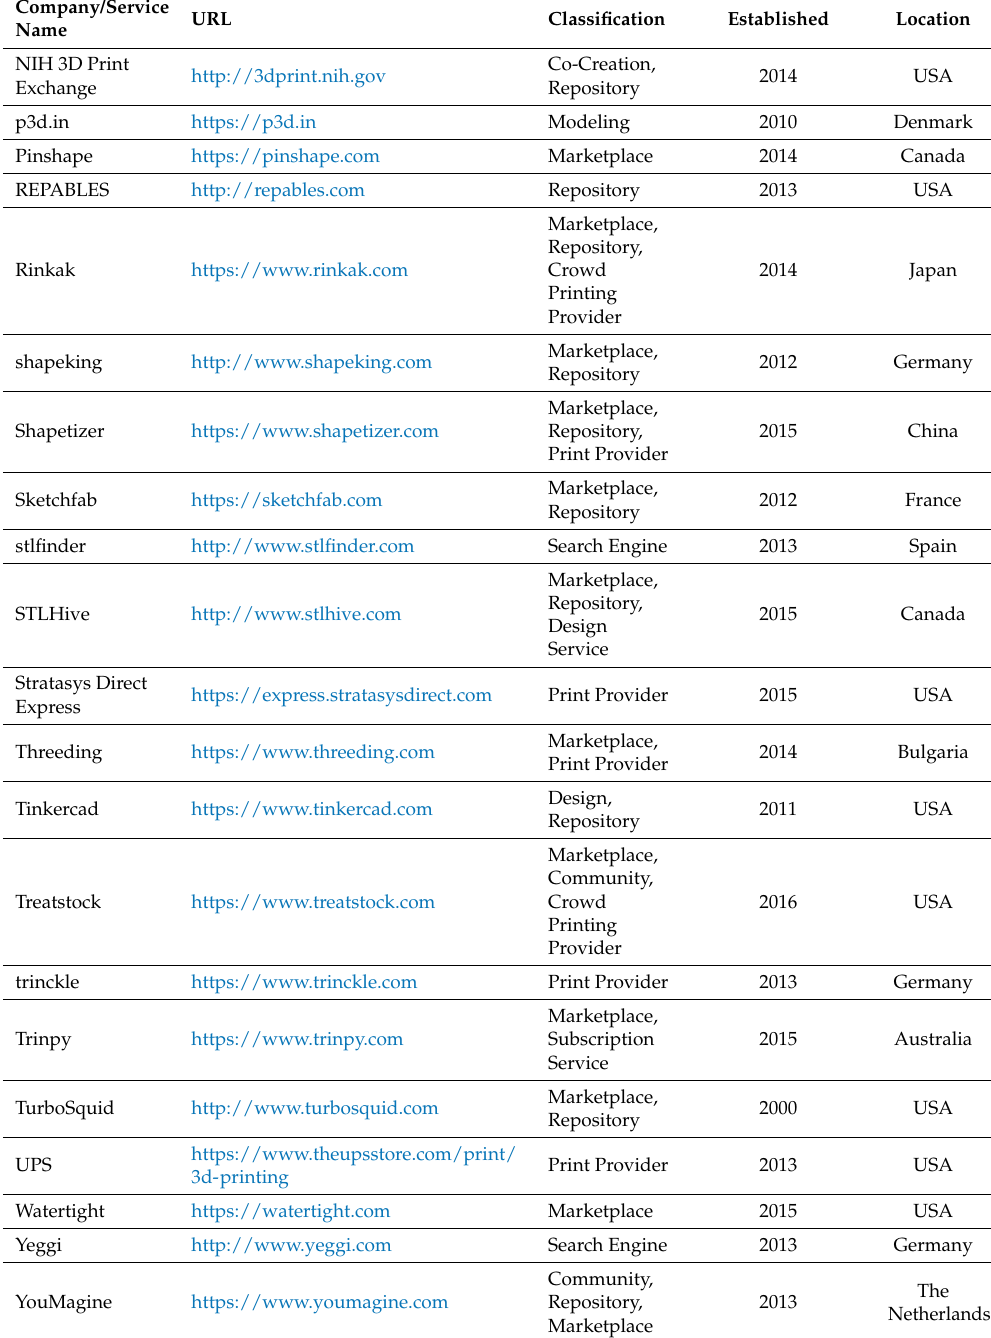
Table 2. 3D printing platforms and services included in this study—Part